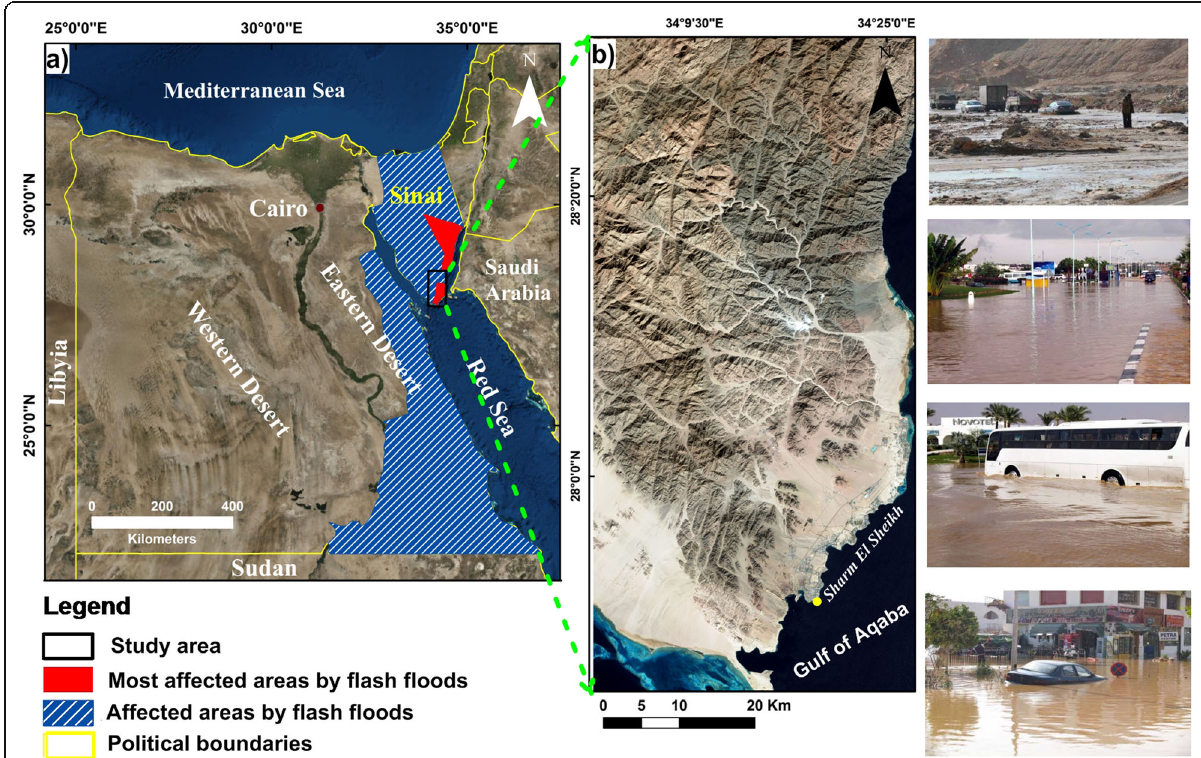
Fig. 1 Key map of the study area. a Map showing the influenced regions by flash floods in Egypt where Sharm El Sheikh area one of the most affected area all over the country (IFRC 2010). b False color composite of Sentinel image showing the study area that includes different touristic resorts along the Gulf of Aqaba coast. The figure is supported by photographs showing the destructive consequences of flash flood occurred in 2010 and related damaged for